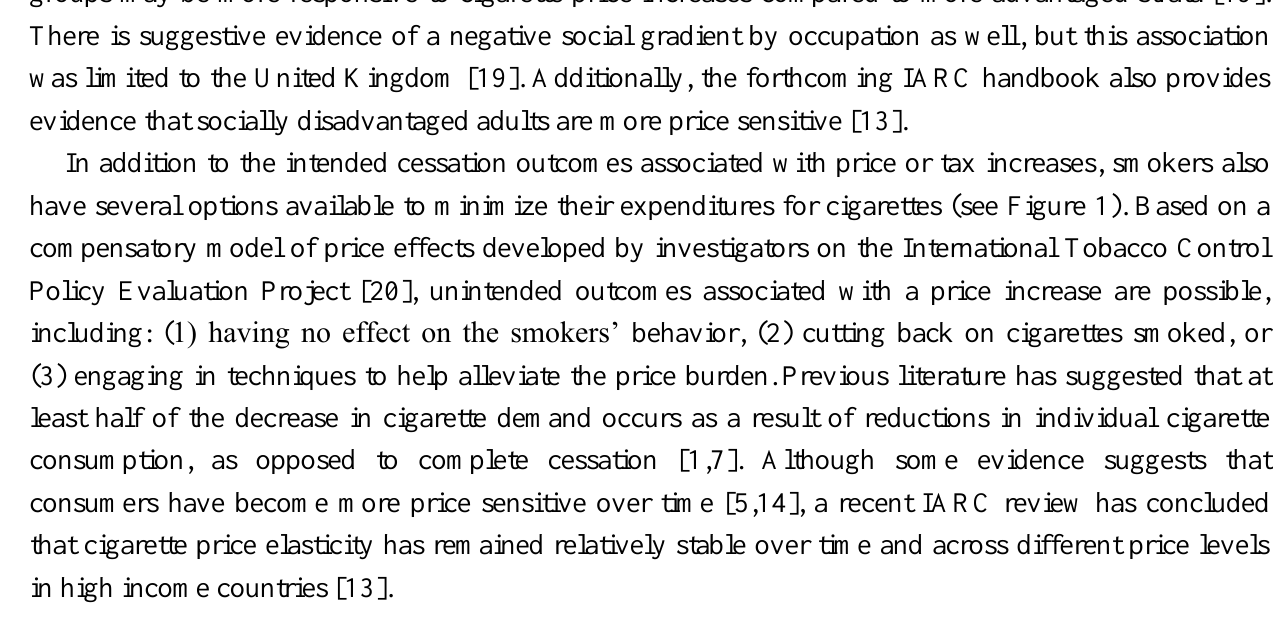
Figure 1. Modified Compensatory Model of Price effects in response to a price or tax